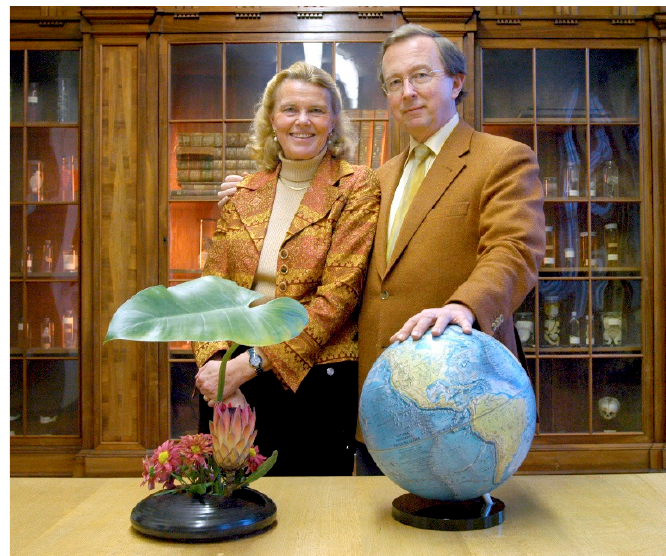
Figure 1. “The Gittenbergers ruling the globe”. Prof. Dr. Adriana C. Gittenberger-de Groot with her husband Prof. Dr. Edi Gittenberger.